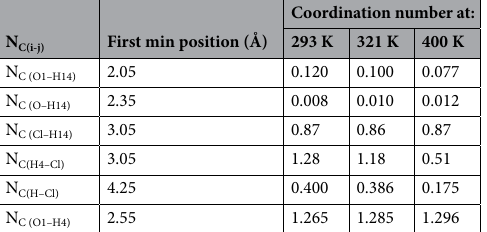
Table 1. Coordination number (N C(i−j) ) of Phpr, choline and chloride iones obtained by molecular dynamics simulations. N C(i−j) represents the number of ith molecules around the jth molecule at the first minimum position of RDFs.